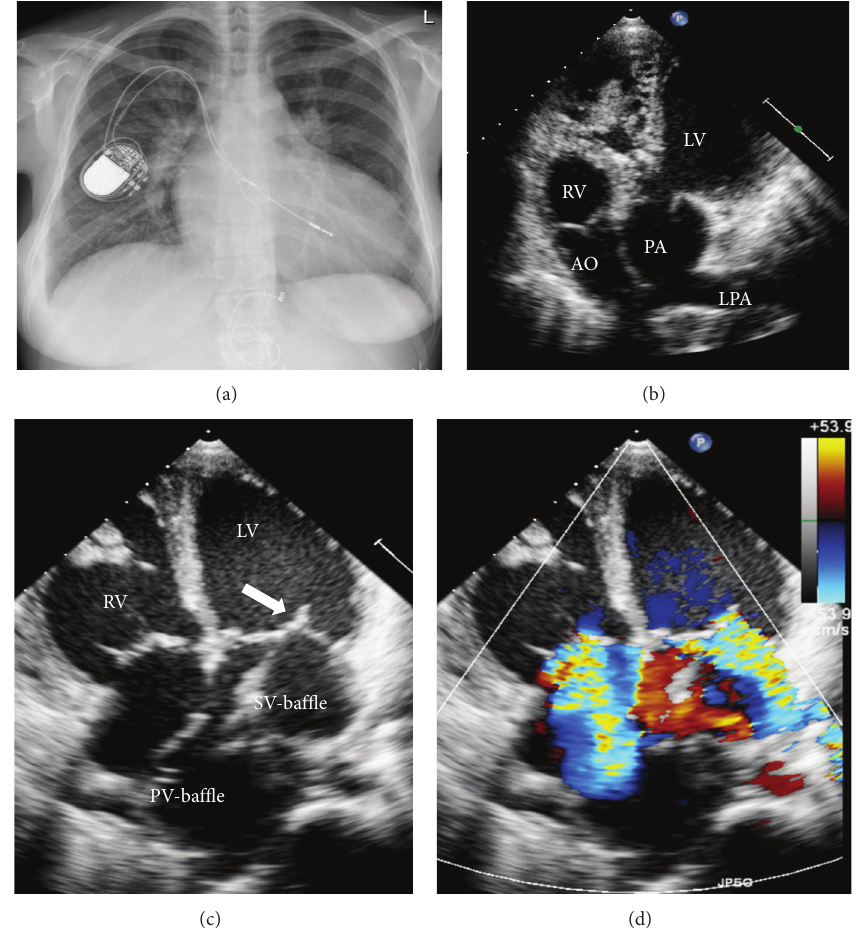
Figure4:32-year-oldpatientwithseverebiventriculardysfunctionafteratrialswitchoperationforcompletetranspositionofthegreatarteries with pacemaker leads in the subpulmonic left ventricle and the systemic venous baffle. (a) Chest X-ray with transvenous pacemaker leads. (b) Apical “5-chamber”-view showing the aorta arising from the morphologic right and the pulmonary artery from the subaortic left ventricle (RV: right ventricle, LV: left ventricle, AO: aorta, PA: main pulmonary artery, LPA: left pulmonary artery). (c) Apical 4-chamber view showing the pulmonary venous and the systemic venous baffles, redirecting venous blood. The arrow points to the pacemaker lead in the subpulmonic left ventricle. (d) Apical 4-chamber view with colour Doppler demonstrating severe (subpulmonic) mitral and severe (systemic) tricuspid